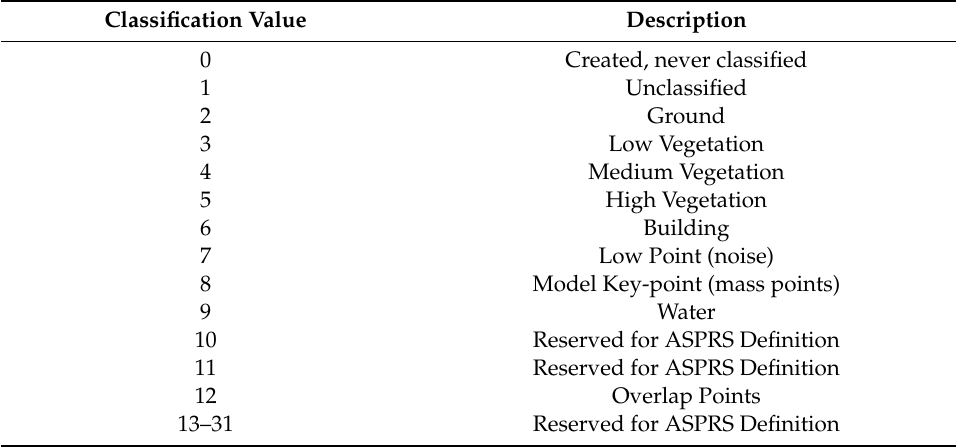
Table 1. American Society of Photogrammetry and Remote Sensing (ASPRS) Standard LiDAR Point Classes (LAS 1.2)